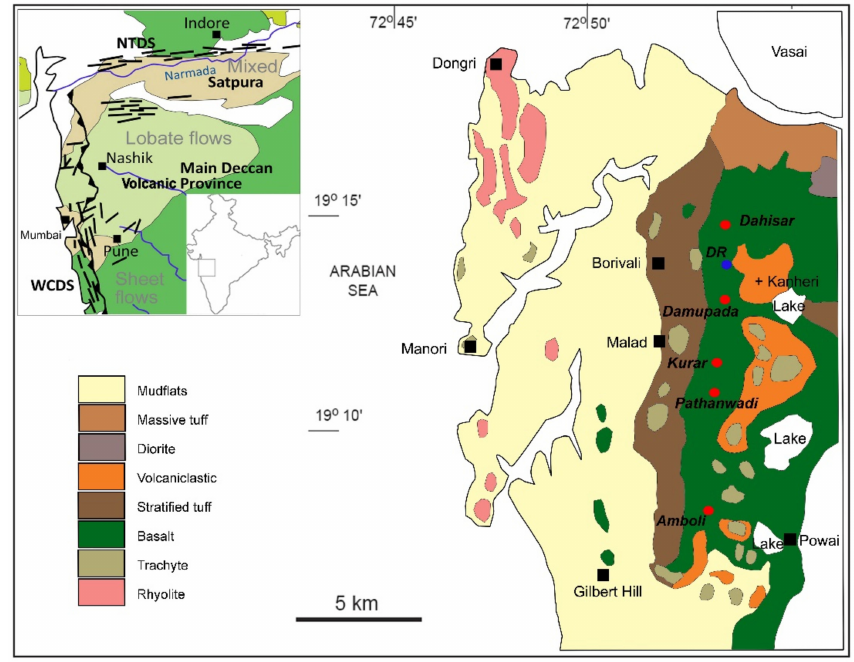
Figure 1. Geological map of Salsette Island, Mumbai (modified after Sheth et al. [31], with the position of the investigated quarries (red dots) and the Dahisar river bed pillows (blue dot and DR,